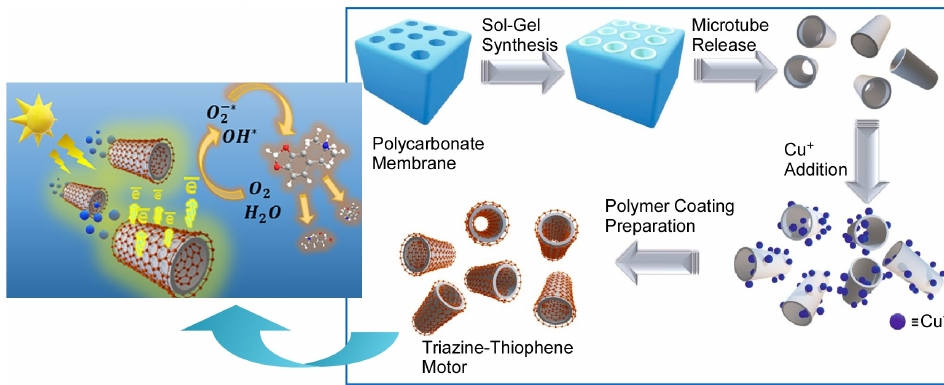
Figure 14. A tubular inorganic/organic hybrid that combines mesoporous silica with active poly- mers containing thiophene and triazine units as photoactive microrobots for efficient directional motion under fuel-free conditions. Reprinted with permission from Reference [158]. Copyright 2021 American Chemical Society.